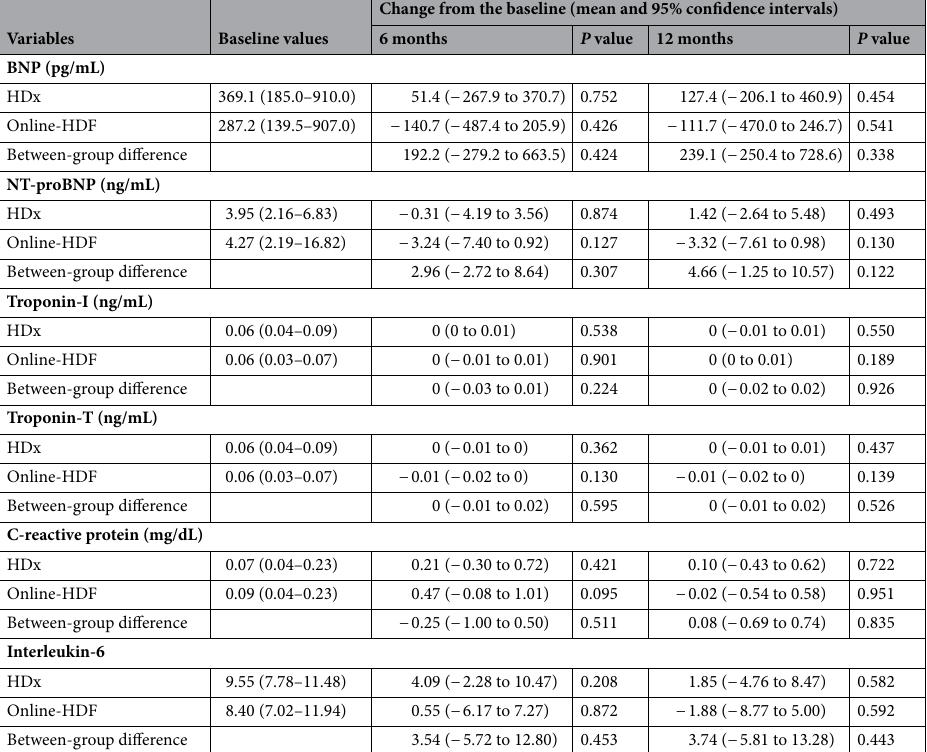
Table 3. Linear mixed-effects model for the change in blood biomarkers. BNP brain natriuretic peptide, HDx expanded hemodialysis, HDF hemodiafiltration, NT-proBNP N-terminal prohormone of brain natriuretic